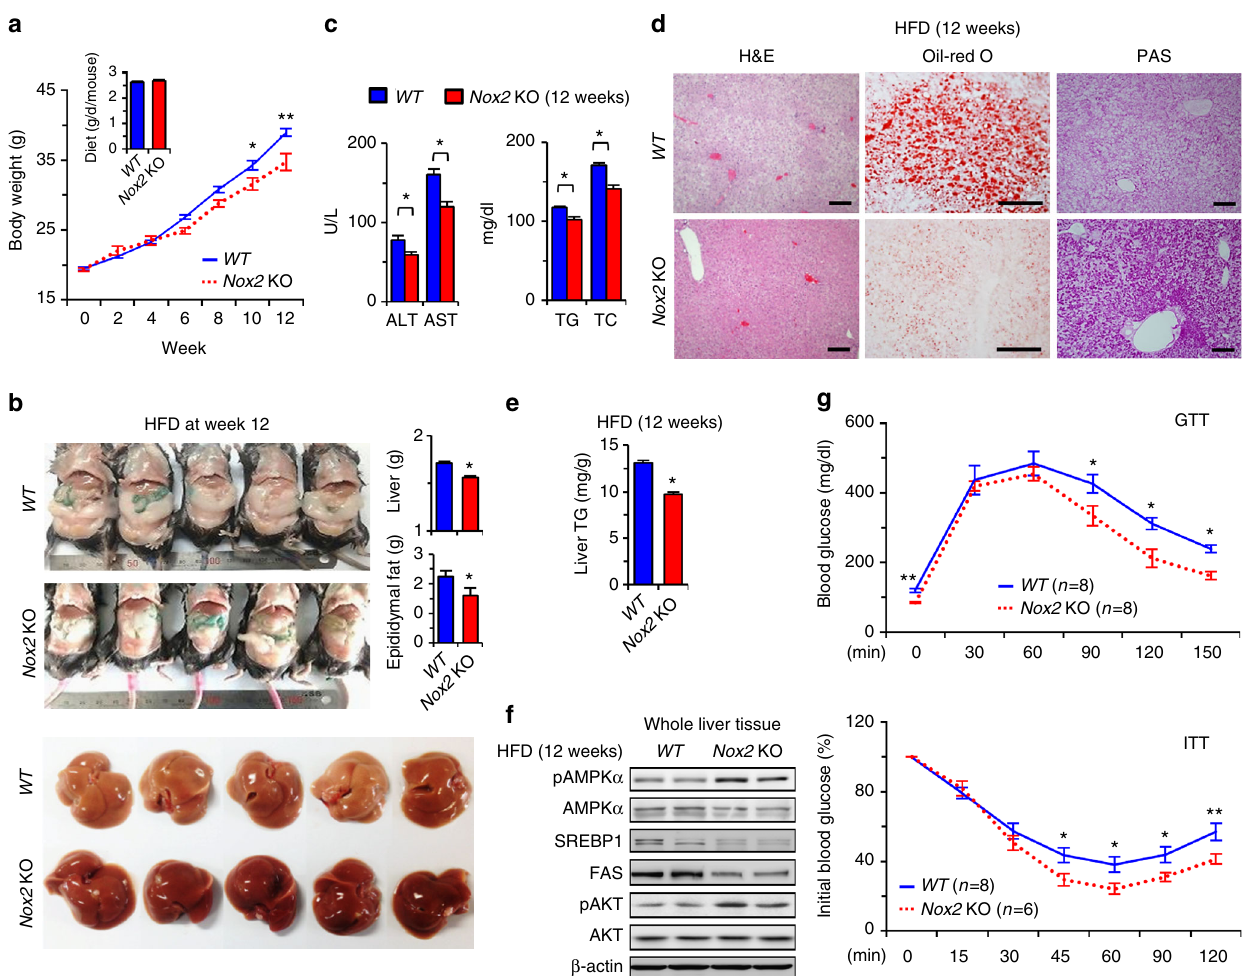
Fig. 1 Ablation of NOX2 ameliorates high-fat diet-induced hepatic steatosis in mice. WT and Nox2 KO mice were fed a high-fat diet for 12 weeks. a Changes in body weight and diet intake. b Representative gross fi ndings and their weights of epididymal fat and liver in WT and Nox2 KO mice at week 12. c Blood chemistry analyses for alanine aminotransferase (ALT), aspartate aminotransferase (AST), triglyceride (TG), and total cholesterol (TC). d Sectioned liver tissues stained with hematoxylin and eosin (H&E), oil-red O (Oil-Red O), and periodic acid-Schiff (PAS). Bar = 100 μ m. e TG levels measured in whole liver tissues. f Liver tissues subjected to Western blotting. g Glucose tolerance tests (GTTs) and insulin tolerance tests (ITTs) performed after 16 h of fasting. Data are representative of three independent experiments using 5 ( a – f ) or 6 – 8 ( g ) mice per group. Data are expressed as the mean ± s.e.m. and analyzed by Student ’ s t -test, * P < 0.05, ** P < 0.01 in comparison with the corresponding Pro-in fl ammatory phenotype of CD11b + F4/80 low macro- nuclei (Fig. 3b; Supplementary Fig. 2a, b). In qRT – PCR analyses, phages . To validate the notion that CD11b + F4/80 low macro- CD11b + F4/80 low macrophages displayed higher expression of phages rather than CD11b + F4/80 high Kupffer cells are responsible Nox2 , Tlr4 and Cd14 than CD11b + F4/80 high Kupffer cells (Fig. 3c). In addition, gene expression of pro-in fl ammatory markers such as Tnf- α and Il-1 β was higher, whereas expression of Il-10 was signi fi cantly lower in CD11b + F4/80 low macrophages than in CD11b + F4/80 high Kupffer cells (Fig. 3d). Interestingly, similar fi ndings were still detected in freshly isolated hepatic macrophages and Kupffer cells isolated from mice fed a HFD for 12 weeks (Supplementary Fig. 2c). Histogram data showed that (Fig. 3a). CD11b + F4/80 high Kupffer cells showed higher expres- expression of TLR4 was similar but expression of CD14 and CD11c was higher in macrophages than those of Kupffer cells sion of CD206 than CD11b + F4/80 low macrophages, with no expression detectable in hepatic lymphocytes, as a re fl ection of a (Fig. 3e). All these data indicate that CD11b + F4/80 low macro- more pro-in fl ammatory phenotype in in fi ltrating macrophages phages show more in fl ammatory phenotype than CD11b + F4/ 80 high Kupffer cells in liver of HFD-fed WT mice. than in Kupffer cells (Fig. 3a). Next, we assessed morphological differences between Kupffer cells and macrophages by sorting and staining with Giemsa solution. Under the microscope, CD11b + F4/80 low macrophages were identi fi ed with their small cyto- palmitate . To explore the roles of TLR4 and NOX2 in ROS gen- plasm and indented nuclei, whereas CD11b + F4/80 high Kupffer eration, isolated macrophages and Kupffer cells of WT, Tlr4 KO and cells showed abundant cytoplasm and marginal location of ovoid Nox2 KO mice were treated with palmitate and then ROS generation